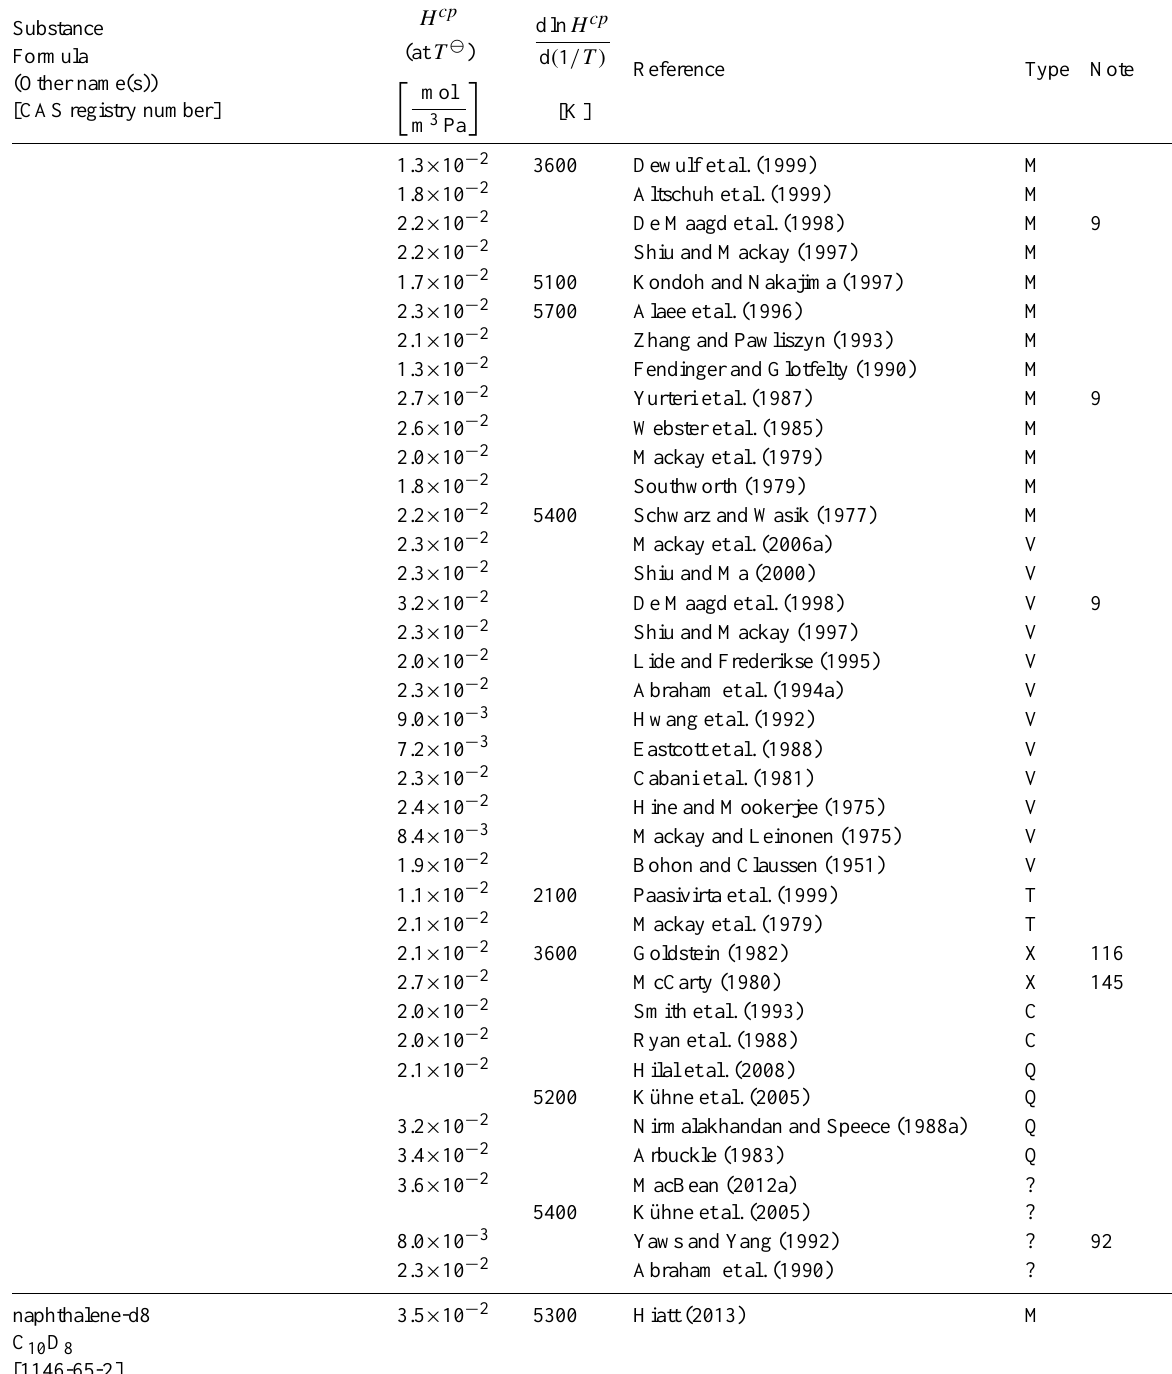
Table 6: Henry’s law constants for water as solvent